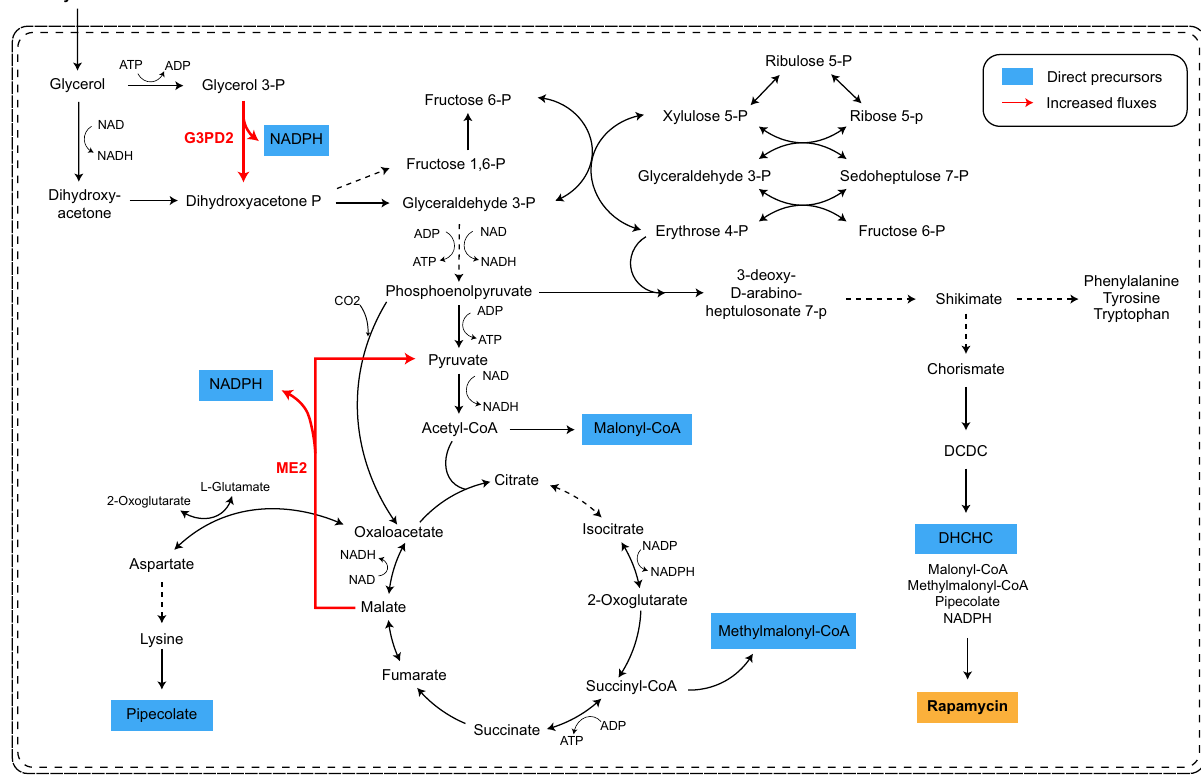
Figure 5. Prediction of intracellular metabolic flux distributions predicted using the genome-scale metabolic models (GEMs) of S. rapamycinicus NRRL 5491 (wild-type) and its mutant SRMK07. Intracellular metabolic flux distributions of the wild-type and the SRMK07 strain were predicted using parsimonious flux balance analysis (pFBA) of the GEMs. Metabolic fluxes predicted to be increased in the SRMK07 strain, compared to the wild-type, are marked with a red arrow. Direct precursors for rapamycin biosynthesis are shown in blue boxes. Dotted arrows indicate multiple reactions. Metabolite abbreviations are: DCDC 4,5-dihydroxycyclohexa-1,5- dienecarboxylic acid, DHCHC 4,5-dihydroxycyclohex-1-enecarboxylic